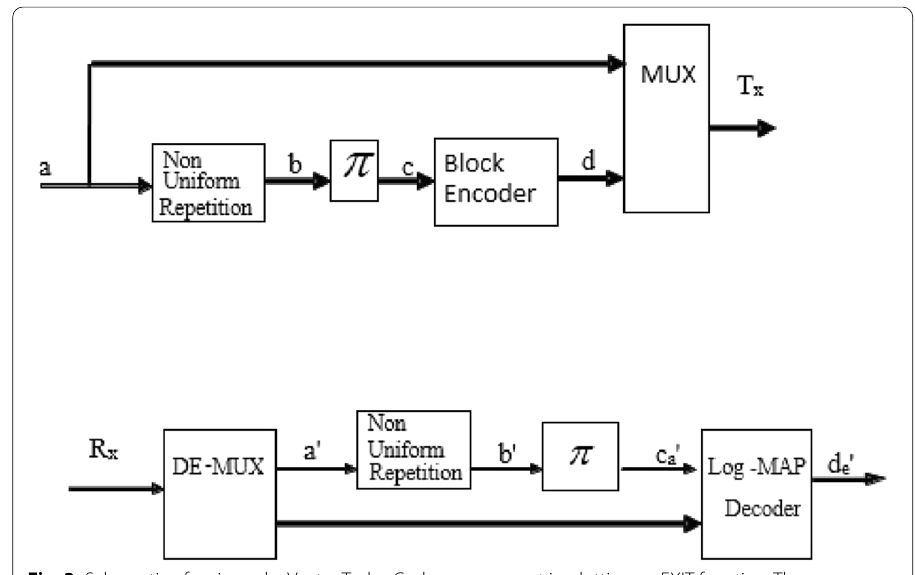
Fig. 3 Schematic of an irregular Vector Turbo Code arrangement in plotting an EXIT function. The corresponding LLR sequences used in the receiver are indicated using an apostrophe. A subscript of “a” indicates a priori information, while a subscript of “e” is used for extrinsic